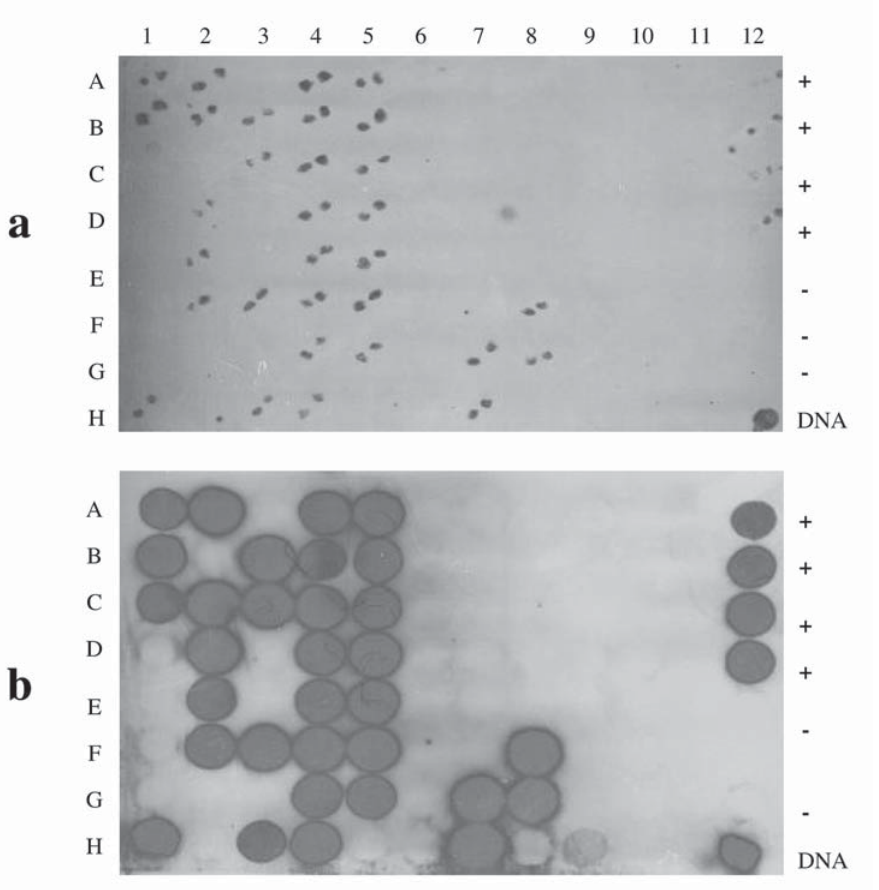
Fig. 1. Comparison of TIH (a) and DBH (b) for detection of PLMVd. Columns 1-H, 2, 3, 4, 5, 6, 7, 8, 9, 10 and 11 are tested samples. A, B and C in column 1, and A, B, C and D in column 12 are positive controls. D, E, F and G in lane 1, and E, F and G in column 12 are negative controls. DNA plasmid control is spotted in column 12-H on both